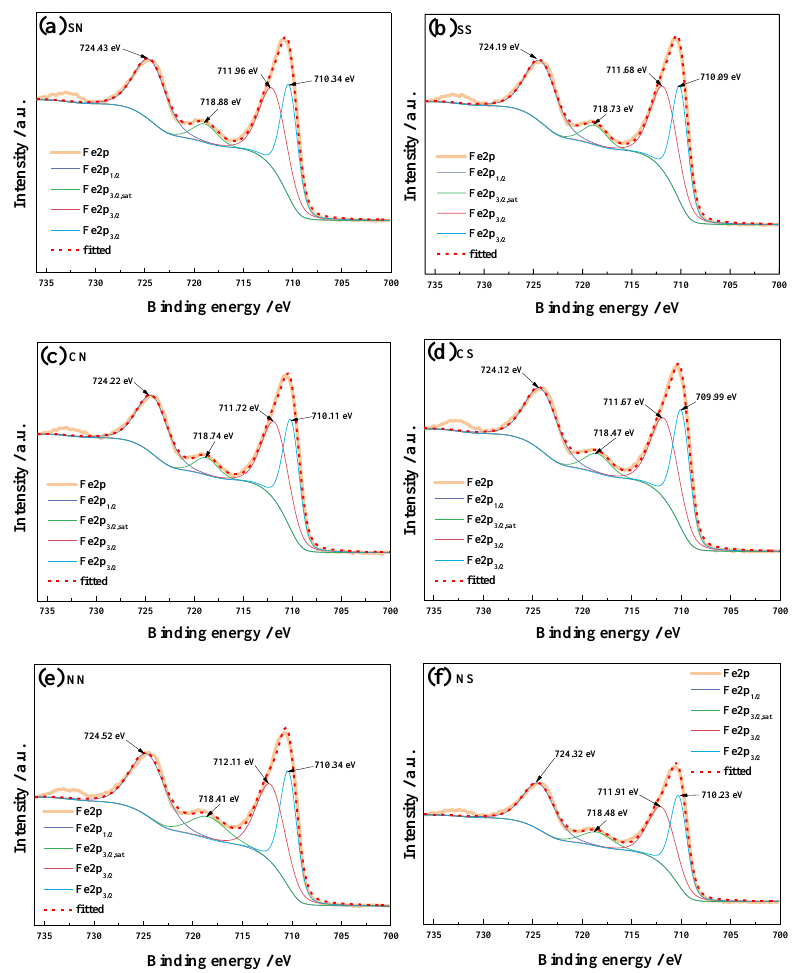
Figure 7. Fe 2p spectra of titanium modified FeMgO x catalysts with different precursors. The O 1s spectra of titanium modified FeMgO x catalysts with different precursors are shown on Figure 8. The O 1s peaks at the binding energy of about 529.8 eV and 531.5 eV were the lattice oxygen (denoted as O β ) and the chemisorbed oxygen (denotes as O α ), respectively, which were both ascribed to O 2− . The intensity of the O 1s peaks of the catalysts NN and NS using Fe(NO 3 ) 3 as precursor was apparently lower than those of the other catalysts, demonstrating that the concentration of oxygen on the surface of the catalysts NN and NS was low. Analyzed by peak-fitting, it could be seen that the chemisorbed oxygen, which was reported most active for the catalysts NN and NS, was significantly poorer, and the concentration of chemisorbed oxygen of the catalyst SN could be up to 21.2% on the surface, which was in accordance with the results above. Meanwhile, the shifting of the O 1s binding energy means that the oxygen deficit was on the surface of the catalyst, which was in favor of the SCR reaction.